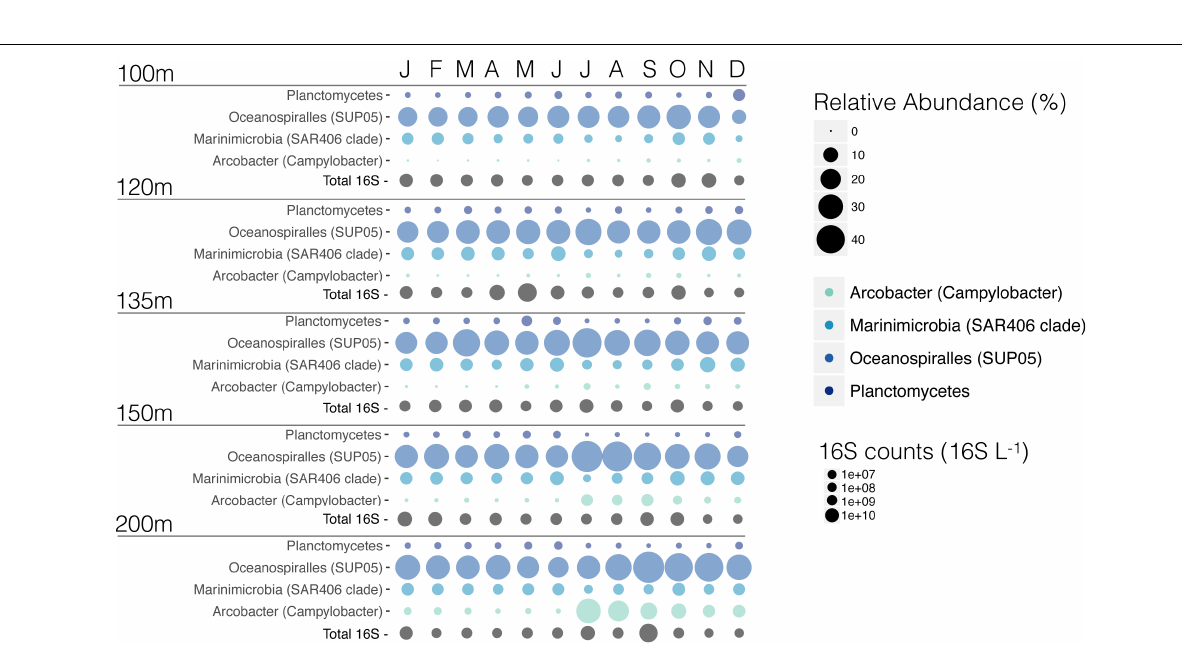
Frontiers in Marine Science |